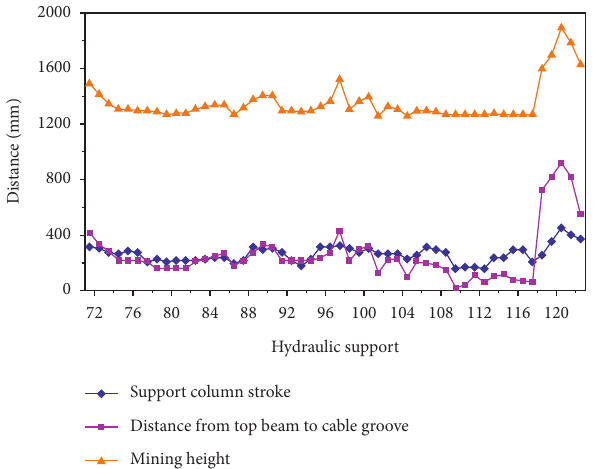
Figure 4: Support state (pillar subsidence) curve for the 22306 working face of the Shigetai